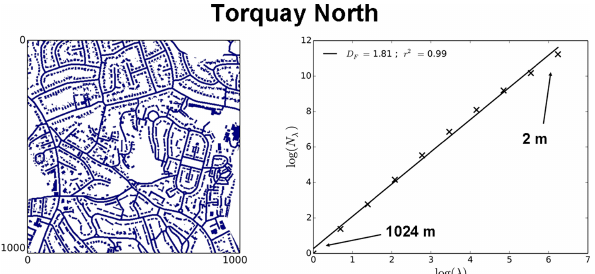
Figure 5. Impervious pixels at a 2m resolution (left) and computa- tion of the fractal dimension of the corresponding geometrical set, i.e. Eq. (1) in log–log plot, (right) for the Torquay north study area. For the left figure, the axes correspond to metres